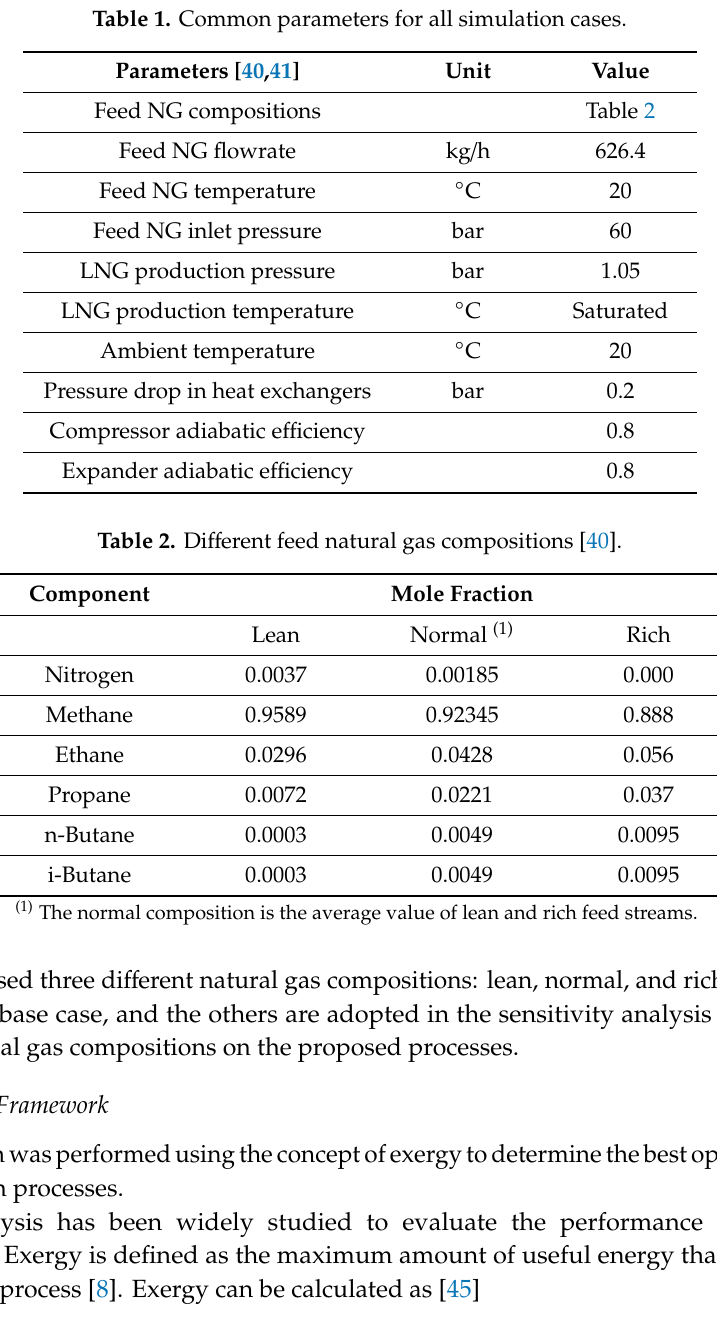
Table 1. Common parameters for all simulation cases.